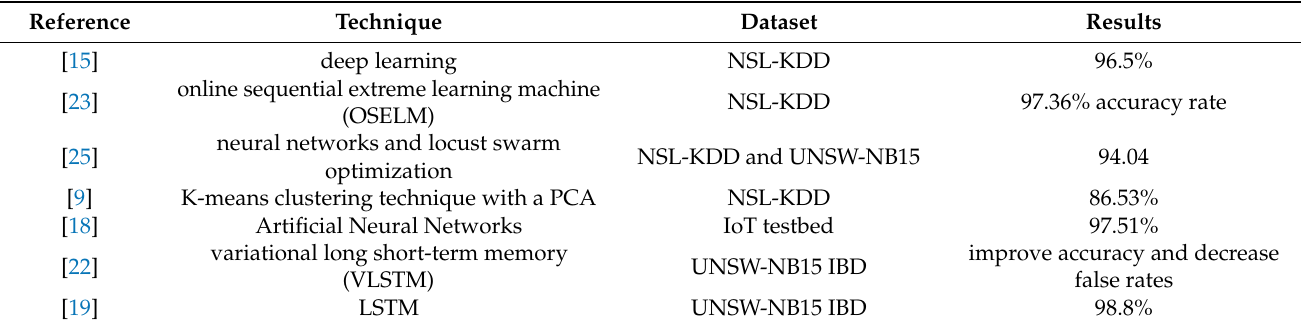
Table 1. Existing work on Anomaly